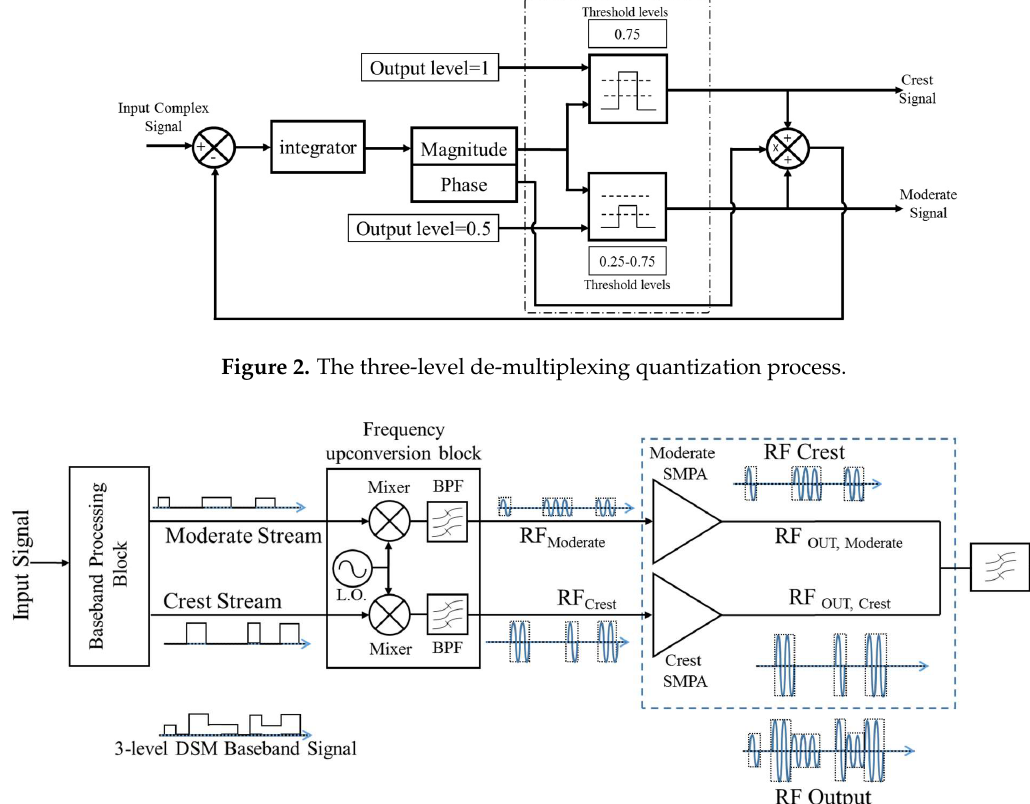
Figure 3. Dual-branch DSM architecture.